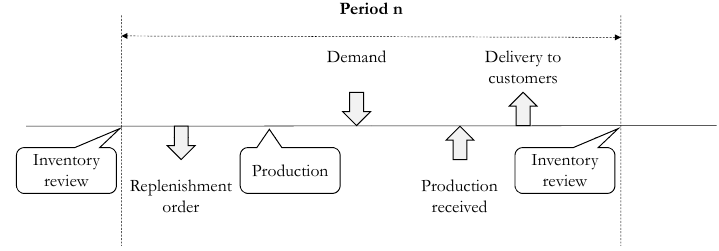
Fig. 1 – Sequence of events. Source: Adapted from Kijima and Takimoto